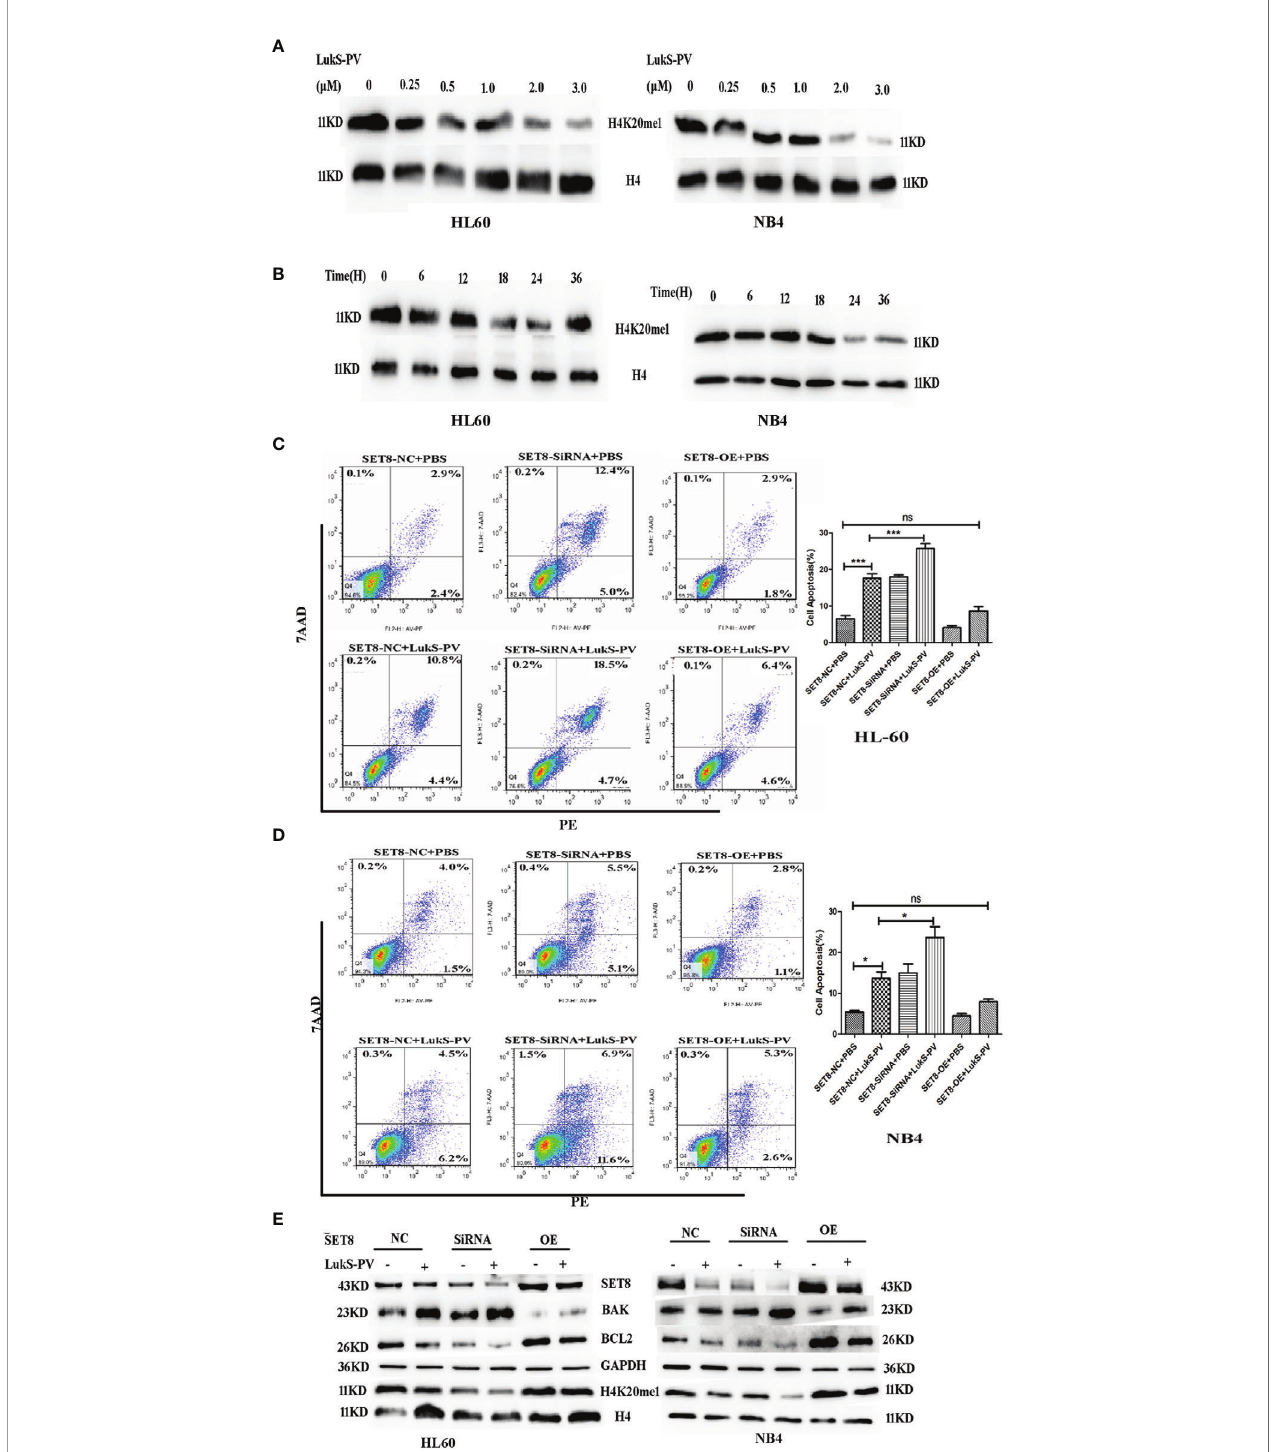
FIGURE 4 | LukS-PV induces apoptosis in acute myeloid leukemia (AML) cells by downregulating SET8/H4K20me1. (A) HL-60 and NB4 cells were treated with LukS-PV at different concentrations for 24 h, and H4K20me1 expression was assessed by Western blotting. (B) HL-60 and NB4 cells were treated with 3.0 m M of LukS-PV at different timepoints, and H4K20me1 expression was assessed by Western blotting. (C, D) SET8 knockdown induced apoptosis and SET8 overexpression inhibited apoptosis in HL-60 (C) and NB4 (D) cells treated with LukS-PV. (E) Expression of SET8 and apoptosis ‐ associated proteins in HL-60 and NB4 cells was assessed by Western blotting. SET8-OE, SET8 overexpression; SET8-NC, SET8 negative control; SET8-siRNA, SET8 small interfering RNA; ns, not signi fi cant; *p < 0.05; ***p <